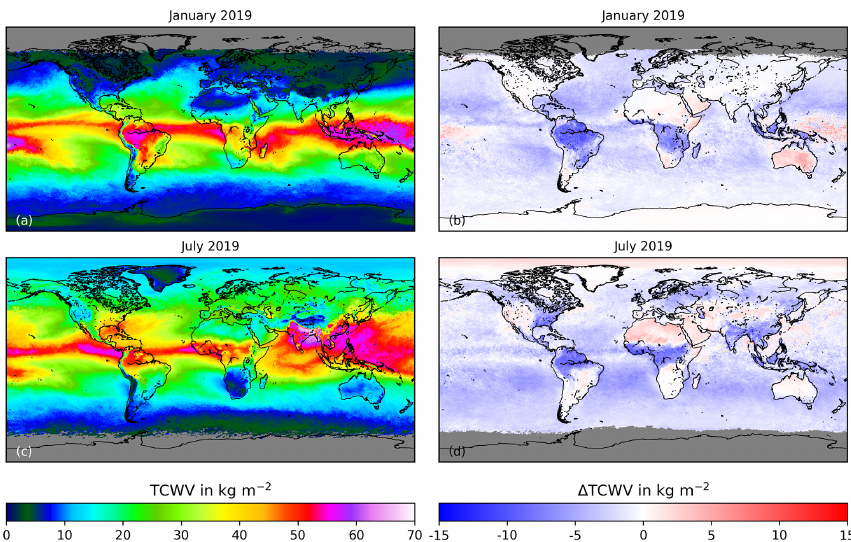
Figure 8. Global map of monthly averaged ERA5 TCWV (a, c) and the difference AMC-DOAS S5P TCWV − ERA5 TCWV (b, d) for January and July 2019 (a–d) .